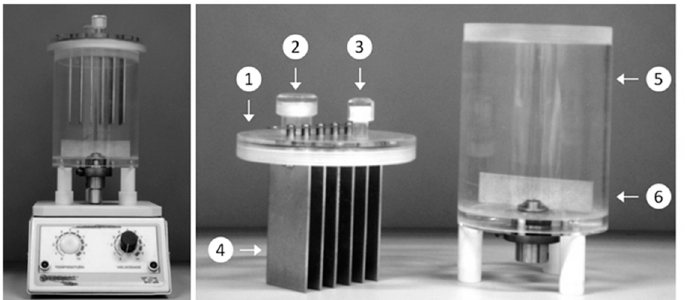
Figure 1. Electroflotation reactor used in the chemical treatment of the wastewater contaminated with the herbicide chlorimuron-ethyl under different conditions and electrochemical parameters.